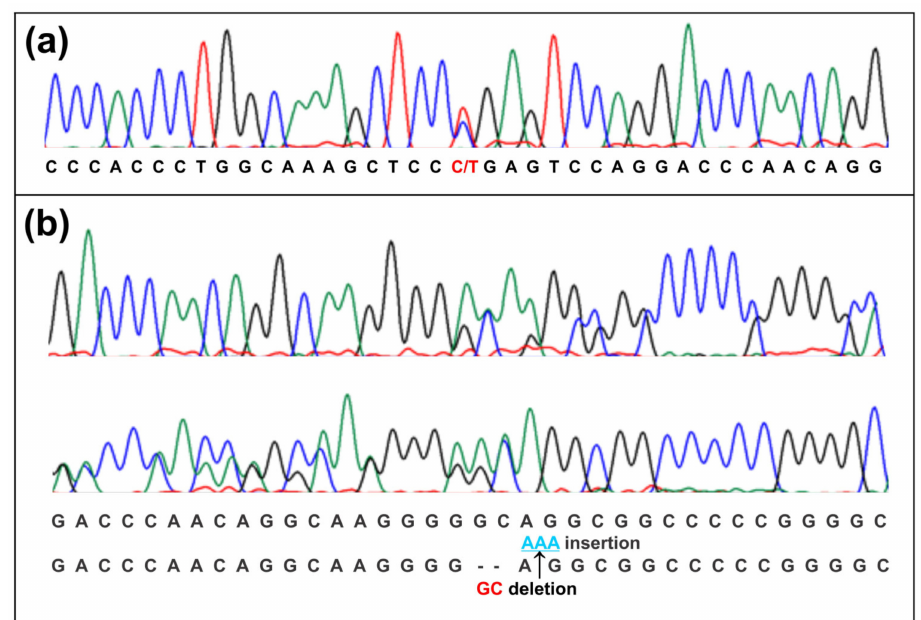
Figure 2. Electropherograms from patient with familial hyperchylomicronemia syndrome showing the sequencing of exon 4 of the GPIHBP1 gene. ( a ) Forward sequenced region showing a transition C > T in heterozygous state, leading to the p.R145* variant; ( b ) forward and reverse sequenced region displaying both a GC deletion and an AAA insertion in cis , rendering the changes p.A154Rfs*152 and p.A154_G155insK,